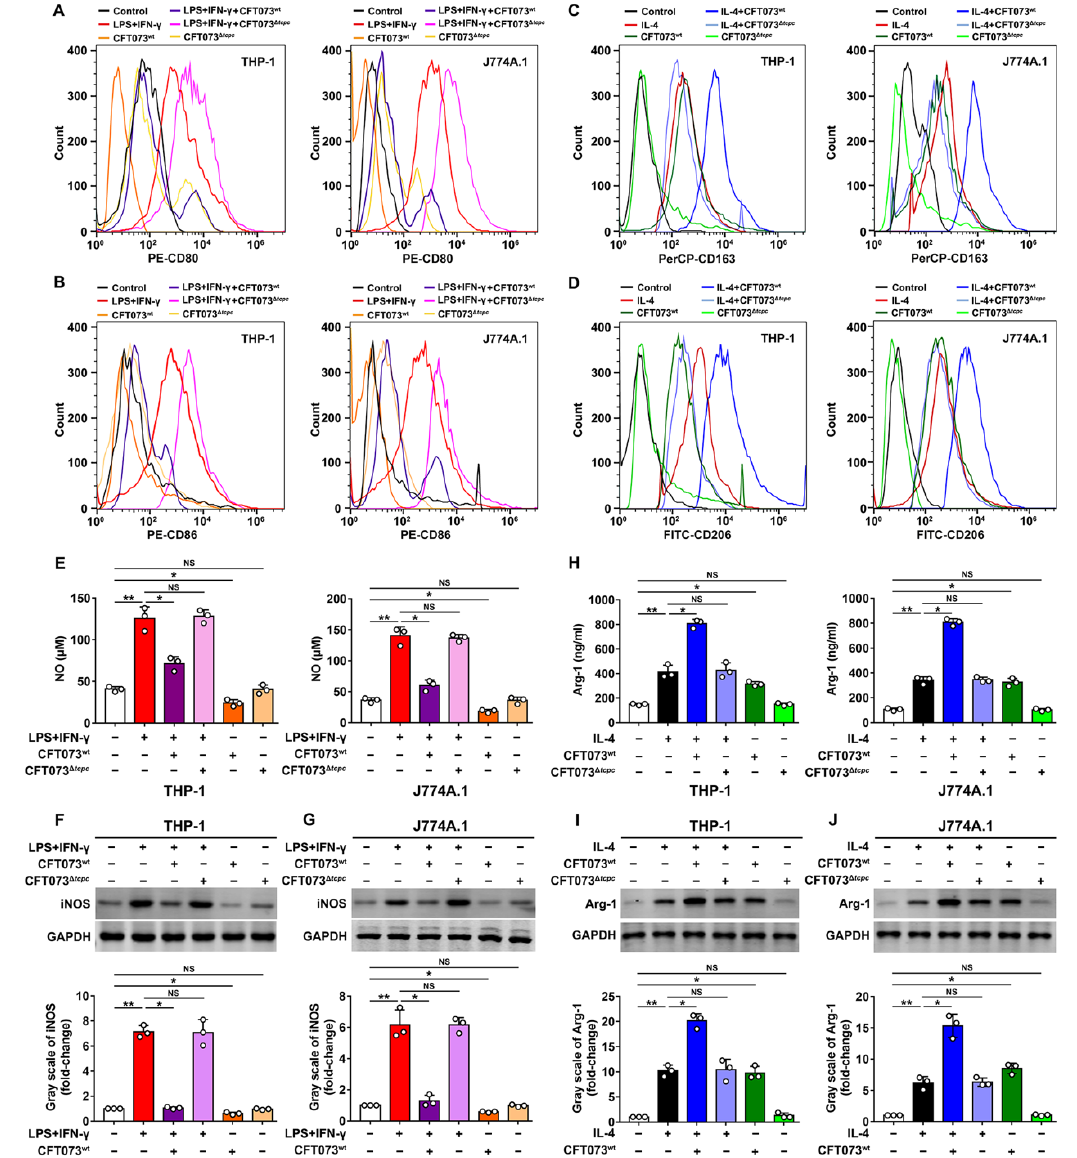
Figure 3. CFT073 wt suppresses M1 but promotes M2 macrophage polarization in vitro. ( A , B ) The expression of M1 surface markers CD80 and CD86 in THP-1 and J774A.1 was detected by flow cytometry. ( C , D ) The expression of M2 surface markers CD163 and CD206 in THP-1 and J774A.1 was analyzed by flow cytometry. ( E ) The production of NO in THP-1 and J774A.1 was measured by Griess method. ( F , G ) The iNOS protein levels and bands ’ gray-scale analyses in THP-1 and J774A.1, respectively. ( H ) The protein levels of Arg-1 in THP-1 and J774A.1 were detected by ELISA. ( I , J ) The protein levels of Arg-1 were detected by Western blot and bands ’ gray-scale analyses in THP-1 and J774A.1, respectively. Gray scale in the control group was set as 1.0. Mean ± SD of three independent experiments are shown. * : p < 0.05; ** : p < 0.01. NS: not significant.